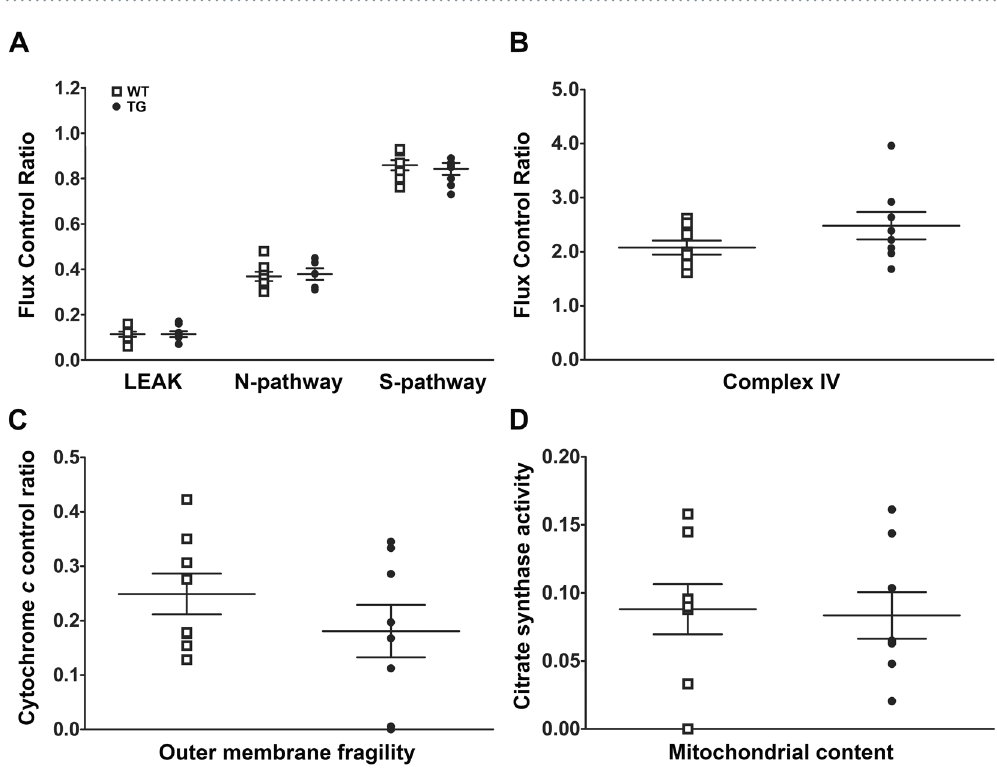
Figure 4. Mitochondrial oxidative phosphorylation and mitochondrial content are preserved. ( A ) Dot plot of flux control ratios for LEAK, NADH (N)- and Succinate (S)- OXPHOS pathways. ( B ) Dot plot presenting flux control ratios for Complex IV single step. ( C ) Dot plot showing cytochrome c control ratio. ( D ) Dot plot of mitochondrial content as assessed by citrate synthase enzymatic activity assays. Data are presented as mean ± SEM; n = 8 independent